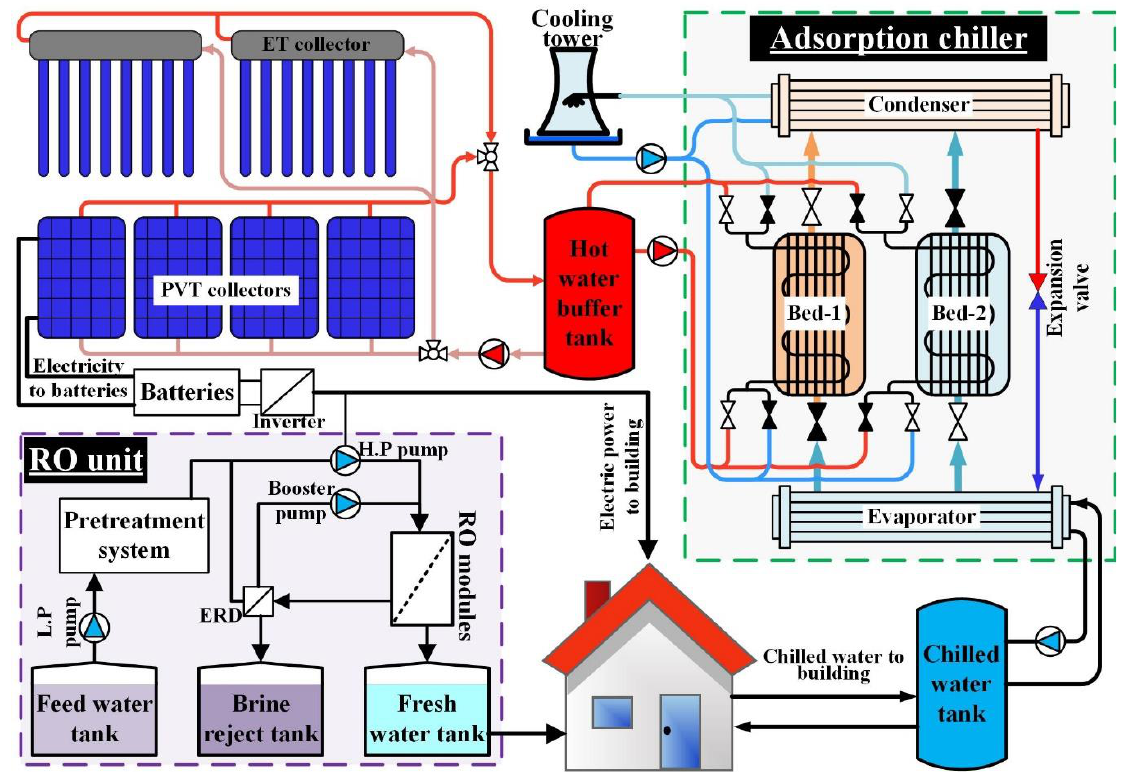
Figure 5. SROC system (adapted from [85]).